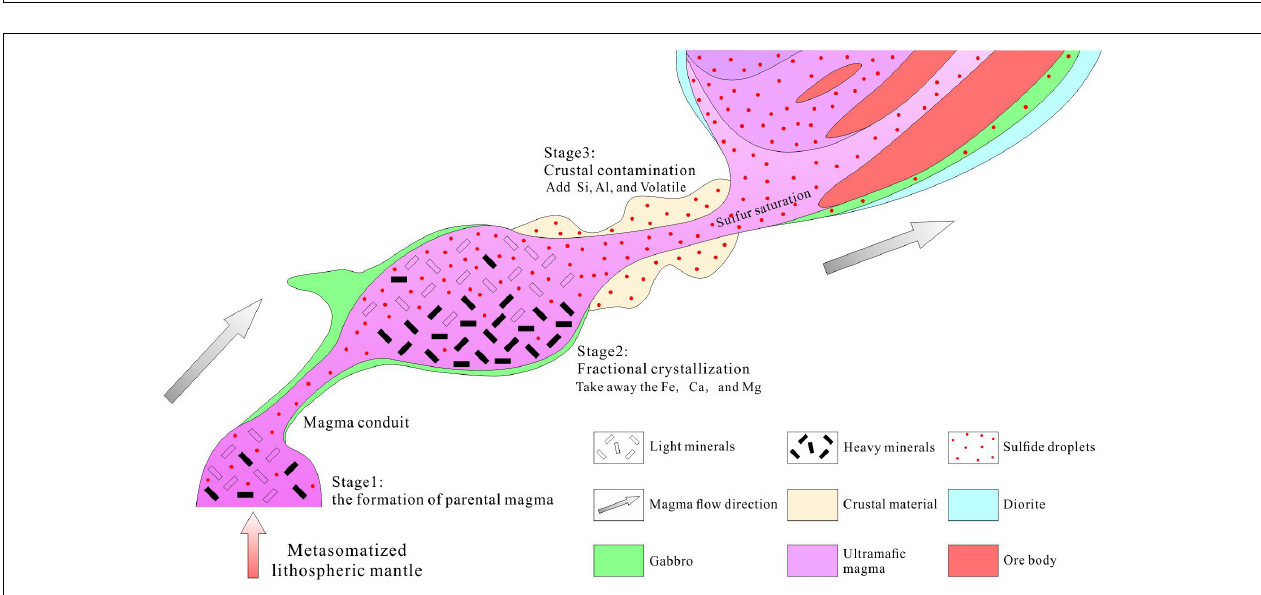
FIGURE 10 | Schematic diagram of pipeline facies mineralization model of Lubei Ni–Cu–Co sulfide deposit (modified from Barnes et al., 2016).